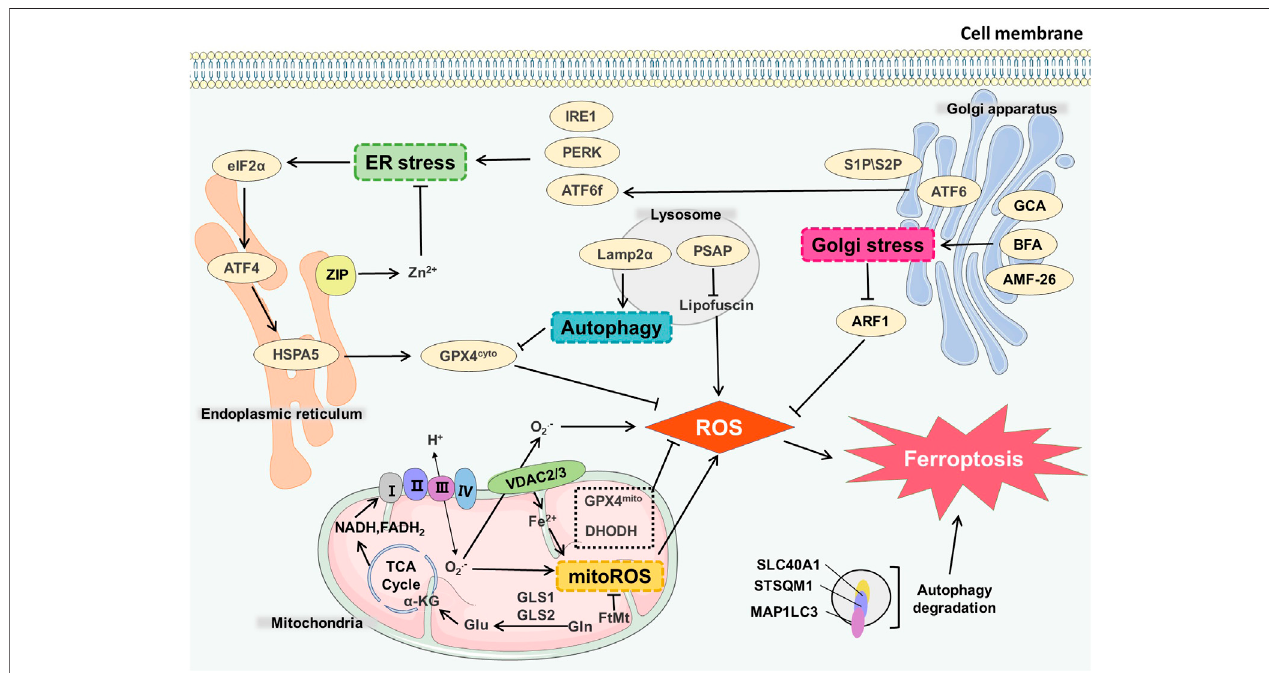
FIGURE2| Organellesandferroptosis.GLS1/GLS2catalyzesGlninthemitochondrialmatrixtogenerateGlu,whichisinvolvedinTCAcycletoproduceNADHand FADH2. After ETC, peroxides and mitoROS were generated. VDAC2/3 on the mitochondrial membrane mediated the maintenance of the steady state of Fe 2+ in mitochondria, which also affected the generation process of mitoROS, and ultimately led to ferroptosis. GCA, BFA, AMF-26 induce Golgi stress and affect ferroptosis. Endoplasmic reticulum stress receptors such as PERK, ATF6, IRE1can also cause endoplasmic reticulum stress-mediated ferroptosis. Autophagy degradation in lysosomes directly infulences the occurrence of ferroptosis. Lamp2 α can inhibit GPX4 by affecting autophagy process, thereby increasing the level of ROS. PSAP can also affect lipofuscin and promote ROS generation.